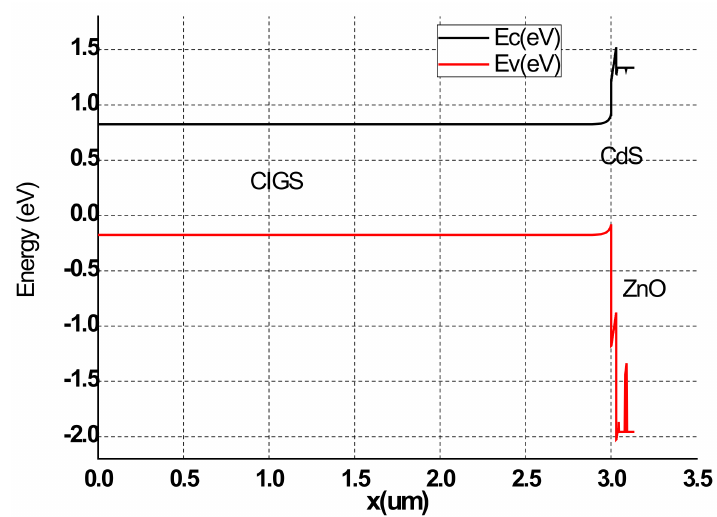
Figure 2. Band diagram for CIGS structure solar cells without BSF.